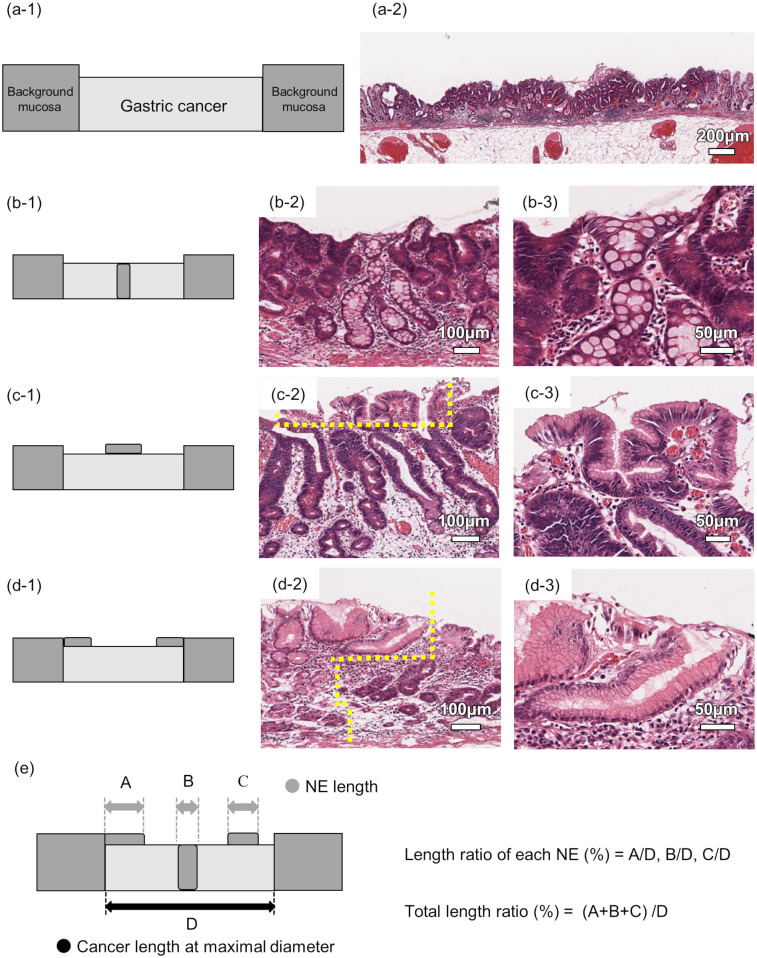
Schematic illustrations and representative micrographs in each type of non-neoplastic epithelium (NE).(a-1) Schematic illustration of gastric cancer (GC) not having NE. (a-2) Representative micrograph of GC not having NE. (b-1) Schematic illustration of full gland type of NE. NE appears from the bottom to the surface of mucosal layer within GC. (b-2) Representative micrograph of full gland type. Micrograph shows a NE gland appears between tubular cancerous glands. (b-3) Micrograph with high-power magnification of full gland type. (c-1) Schematic illustration of internal surface type. NE appears superficially in the internal area of GC. (c-2) Representative micrograph of internal surface type NE. Micrograph shows that NE lies atop tubular cancerous glands. The superficial part of the yellow dotted line represents the field of internal surface type NE. (c-3) Micrograph with high-power magnification of internal surface type. (d-1) Schematic illustration of marginal surface type. NE appears continuously from the background mucosa. (d-2) Representative micrograph of marginal surface type. Micrograph shows that NE continuing from the background mucosa covers the tubular cancerous glands. The left side of the yellow dotted line represents the field of non-cancerous mucosa and the right side represents the field of cancerous mucosa. (d-3) Micrograph with high-power magnification of marginal surface type. (e) The method of measuring the NE length ratio. The NE length ratio is the total length of the NE divided by the length of the cancer measured using the representative histologic section with the maximal cancer diameter, multiplied by 100. (a-2, low power magnification, scale bar = 200 μm; b-2, c-2, d-2, middle power magnification, scale bar = 100 μm; b-3, c-3, d-3, high power magnification, scale bar = 50 μm).